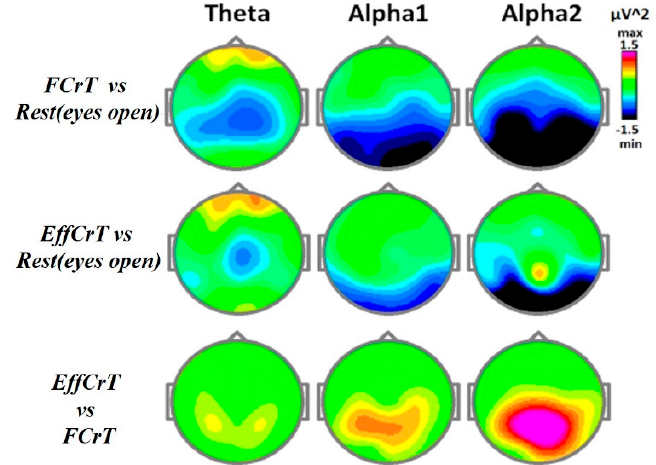
Figure 2. Topographical maps of the spectral power changes during “free creation task” fulfillment and “effortful creation task”